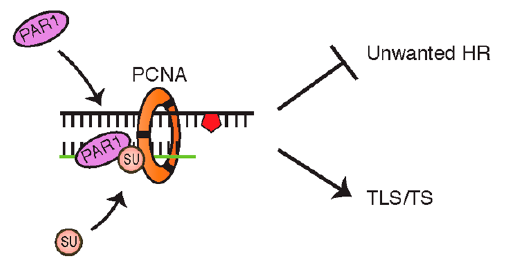
Figure 5. Schematic illustrating the binding of PCNA-associated recombination inhibitor (PAR1) to SUMOylated PCNA functioning to suppress unwanted recombination.